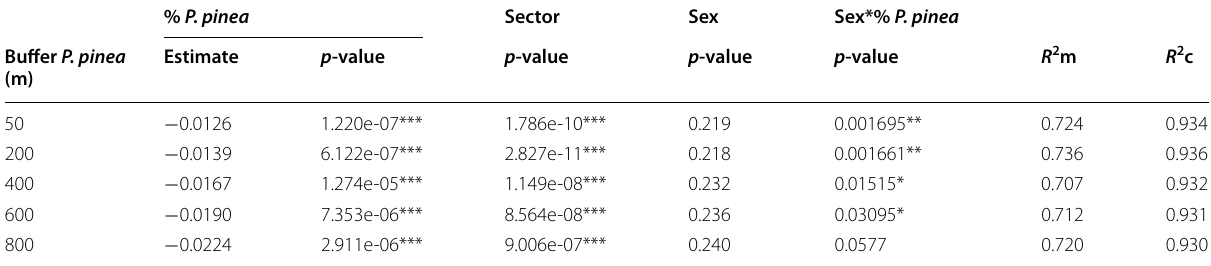
Table 4 Results of the best linear mixed model for each buffer size around the traps (with sector in the fixed part of the model) . Significance of each explanatory variable is given ( P ‑value), and for the % P. pinea , the estimate is also provided. R 2 m corresponds to the variance explained by the fixed effects and R 2 c to the variance explained by fixed and random effects (trap within stand) % P.